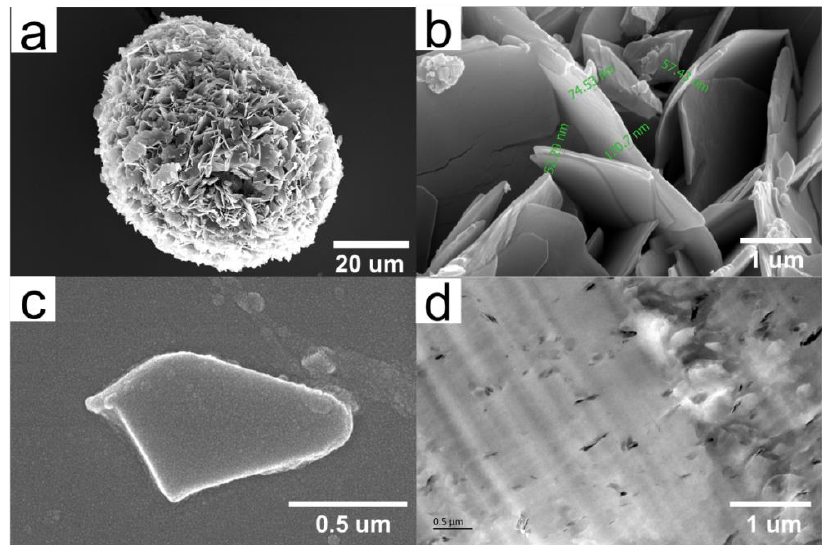
Figure 4. SEM images of BA-MA ( a – c ) and TEM images of PS/BA-MA ( d ).